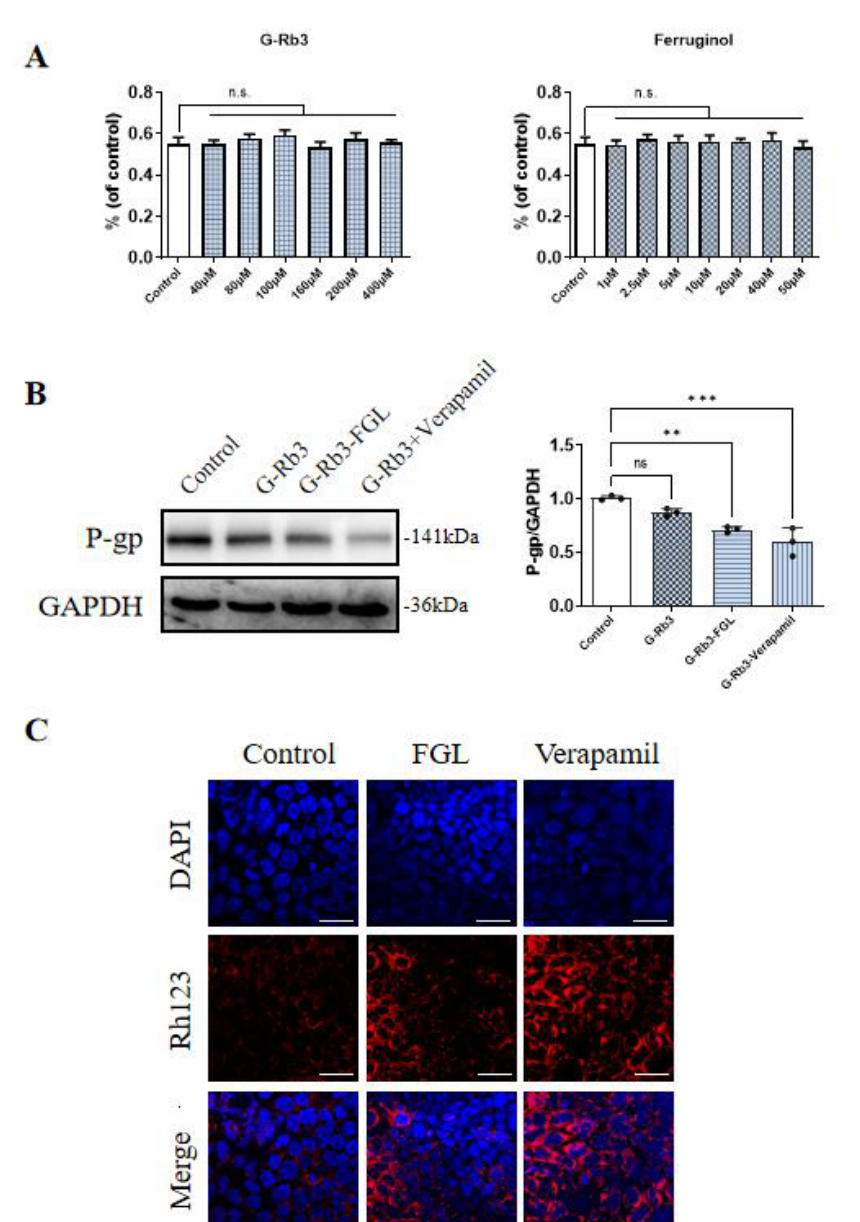
Figure 7. G-Rb3-FGL co-treatment inhibited P-gp expression. ( A ) Cell relative viability of G-Rb3 and FGL alone in Caco-2 cells. ( B ) Representative immunoblots and the quantification of P-gp in different groups. N = 3 per group. ( C ) The results of Rh123 staining ( × 100). Red fluorescence of the Rh123 and blue fluorescence of the nucleus. ns No statistical significance, ** p < 0.01, *** p < 0.001 vs. model group.